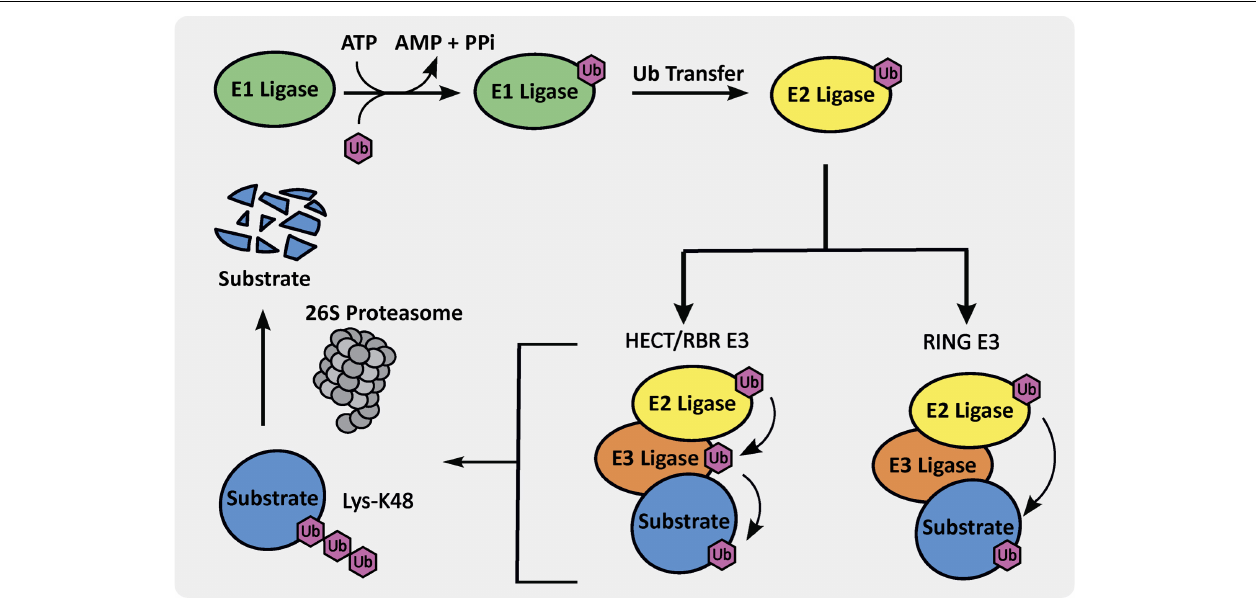
FIGURE 1 | The ubiquitin proteasome system (UPS)